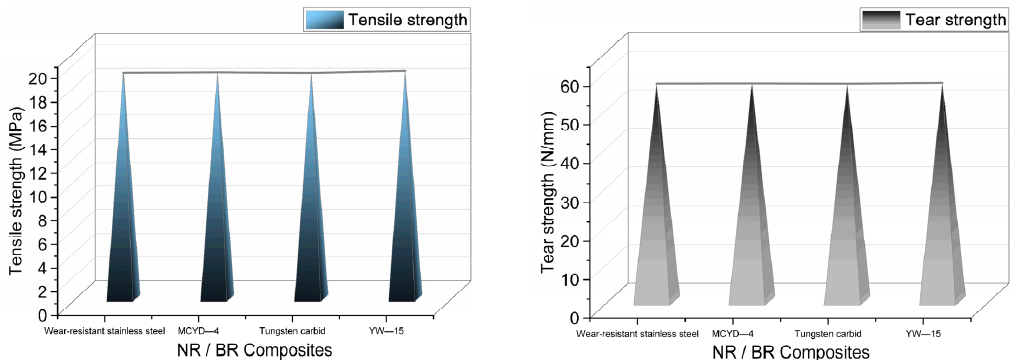
Figure 6. Tensile strength and tear strength of NR/BR composites after friction with different metals.